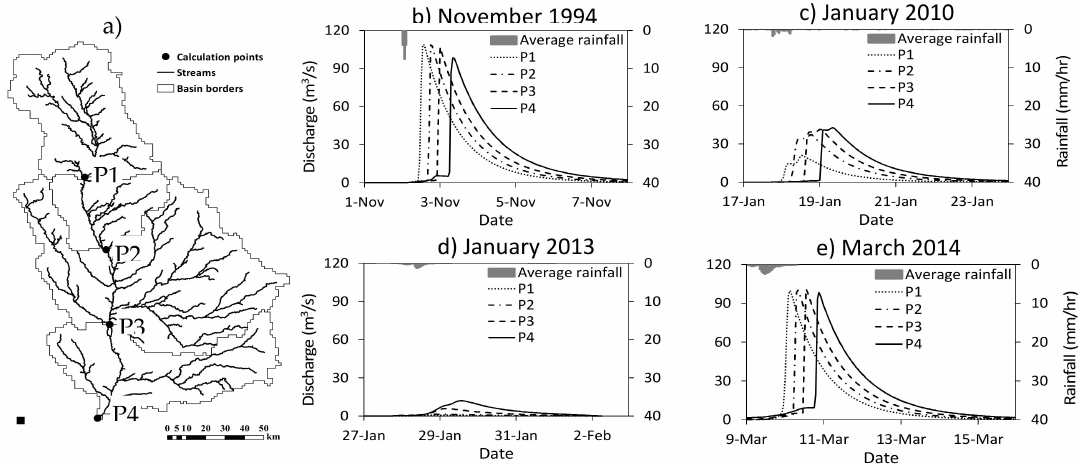
Figure 8. ( a ) Wadi Qena watershed and locations where the simulated floods hydrographs are shown; for the ( b ) November 1994, ( c ) January 2010, ( d ) January 2013 and ( e ) March 2014 flood